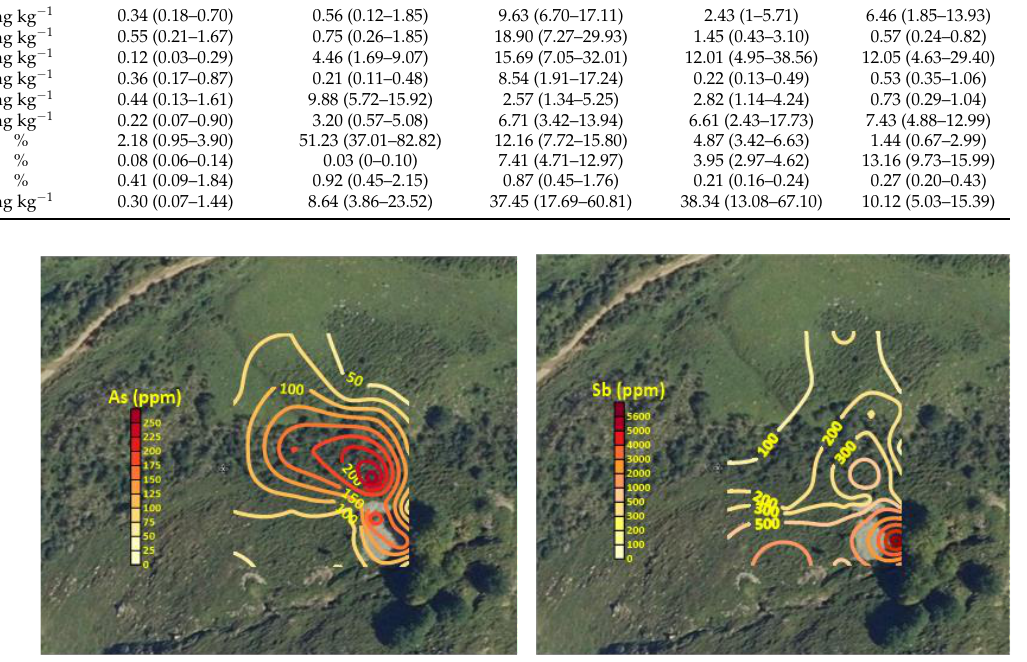
Figure 4. Geochemical maps showing the spatial distribution of the concentrations of As and Sb concentration (mg kg −1 ) in the sampled area (horizontal framing: 190 m). Table 1. Column 2: Average content of selected elements in the sampled soils. Columns 3 – 7: Aver- age extraction percentages from total content obtained in each step of the SEP. Ranges of values are indicated in the brackets.